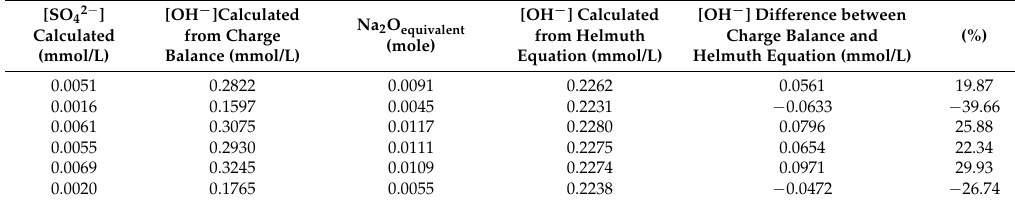
Table 11. SO 42 − and OH − concentrations in the pore